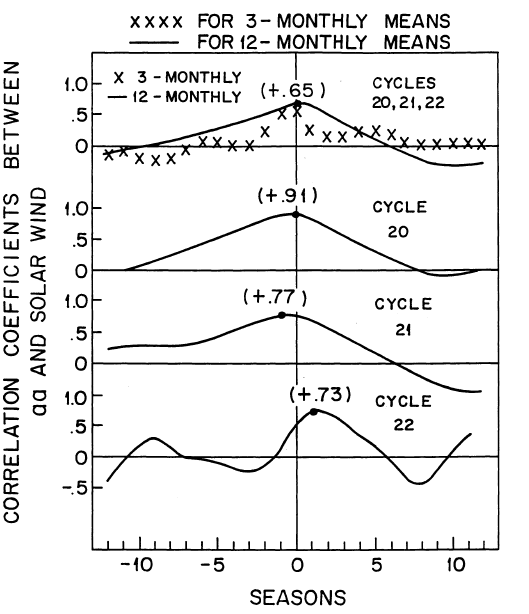
Fig. 10. Cross-correlations between solar wind and aa indices. Crosses , 3-monthly values; solid lines , 12-monthly values